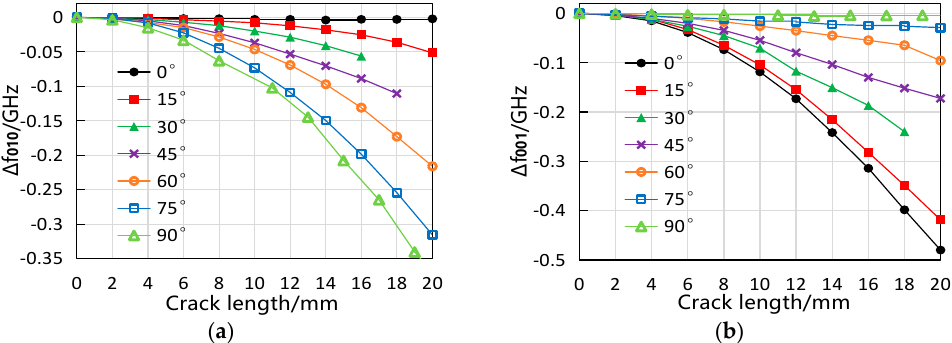
Figure 12. Measured resonant frequency response to cracks located at the center of the ground plane. ( a ) f 010 results and ( b ) f 001 results.